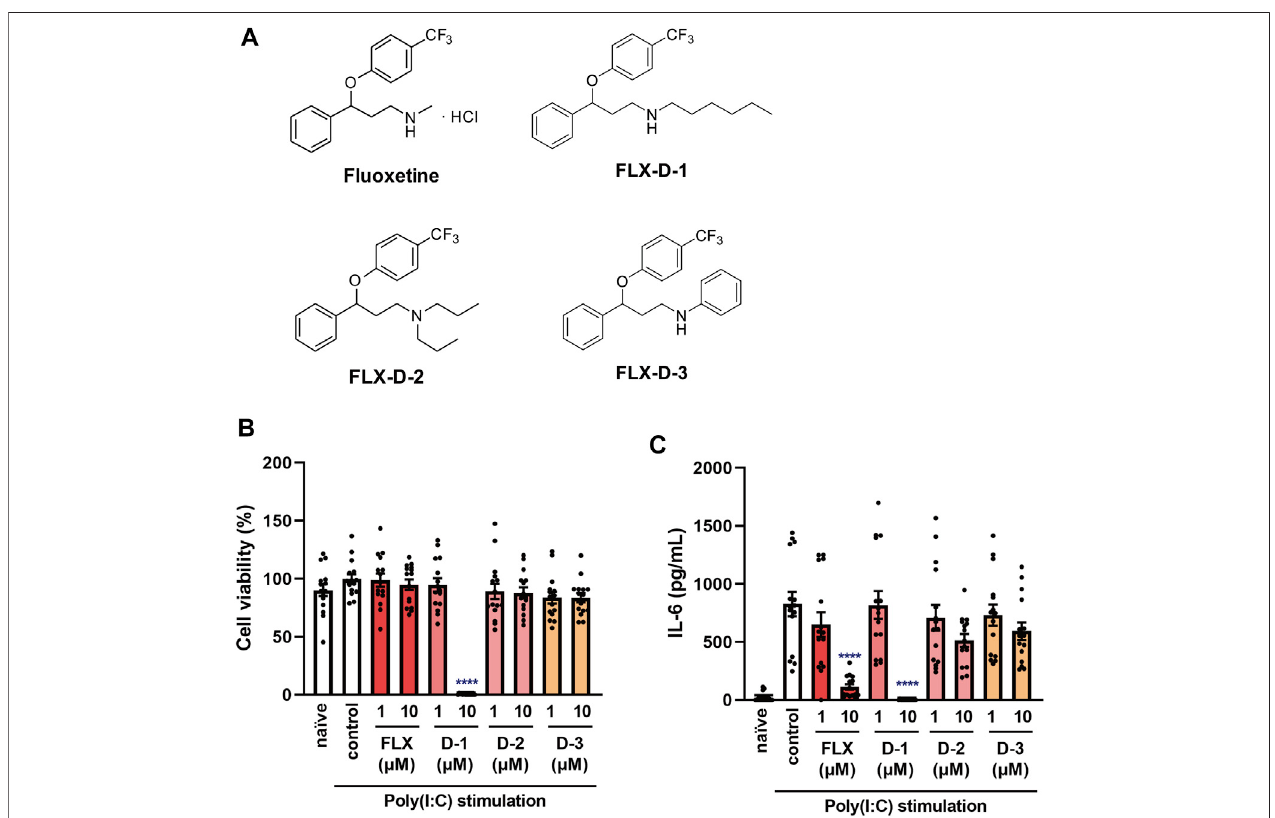
FIGURE 10 | Effects of fl uoxetine derivatives on cell viability and IL-6 production induced by a TLR3 agonist in J774.1 murine macrophage cells. (A) Structural formulas of fl uoxetine and its derivatives. (B,C) J774.1 cells were pre-incubated with each fl uoxetine derivative (FLX-D1, -D2, -D3) (1, 10 µM) for 30 min and then incubatedwithpoly(I:C)(5 μ g/ml)for6 h. (B) CellviabilitywasevaluatedbyMTTassay. (C) IL-6wasmeasuredbymeansofELISA.Errorbarsindicate±SE[ (B,C) : n =15, four independentexperiments).Statisticalanalysiswasperformedbyone-wayANOVA followedbyDunnett ’ stest. Signi fi cantdifferencesbetweencontroland test groups are indicated by **** p < 0.0001. FLX, fl uoxetine. D-1: FLX-D1, D-2: FLX-D2, D-3: